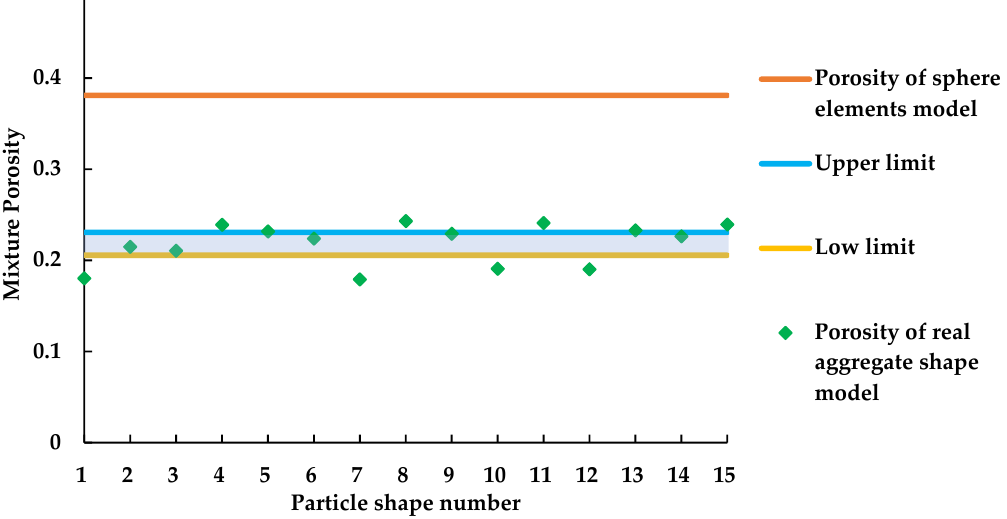
Figure 13. Mixture porosity comparison between sphere elements model and real aggregate shape model.